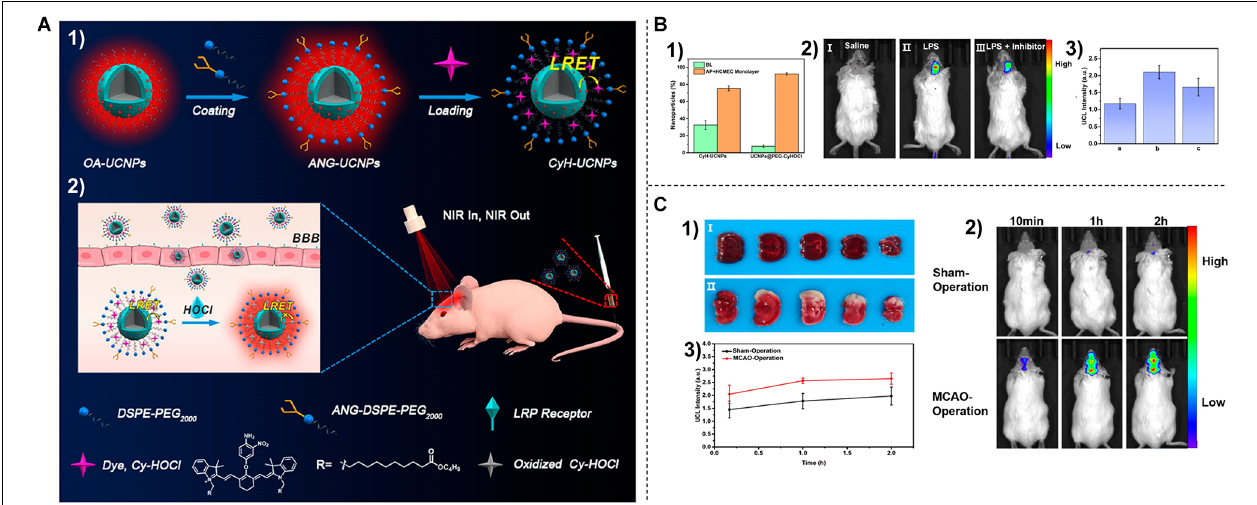
FIGURE 3 | (A) P receptor-mediated NI endocytosis and probe response to HOCl (2) . (B) Distribution of nanoparticles after 18 h incubation in an in vitro blood-brain barrier model (1) . (2) In vivo UCL imaging of NI models after injection of saline (I), lipopolysaccharide (II), and lipopolysaccharide + minocycline (III) and their normalized UCL intensities (3) . (C) (1) TTC staining results of mice in sham-operated group (I) and middle cerebral artery ligation group (II). (2) In vivo UCL visualization of NI in stroke model at different time points after intravenous injection of CYH-UCNPs. (3) Normalized UCL intensity in (2) . Reprinted (adapted) with permission from Zhang et al. (2020). Copyright 2020 American Chemical